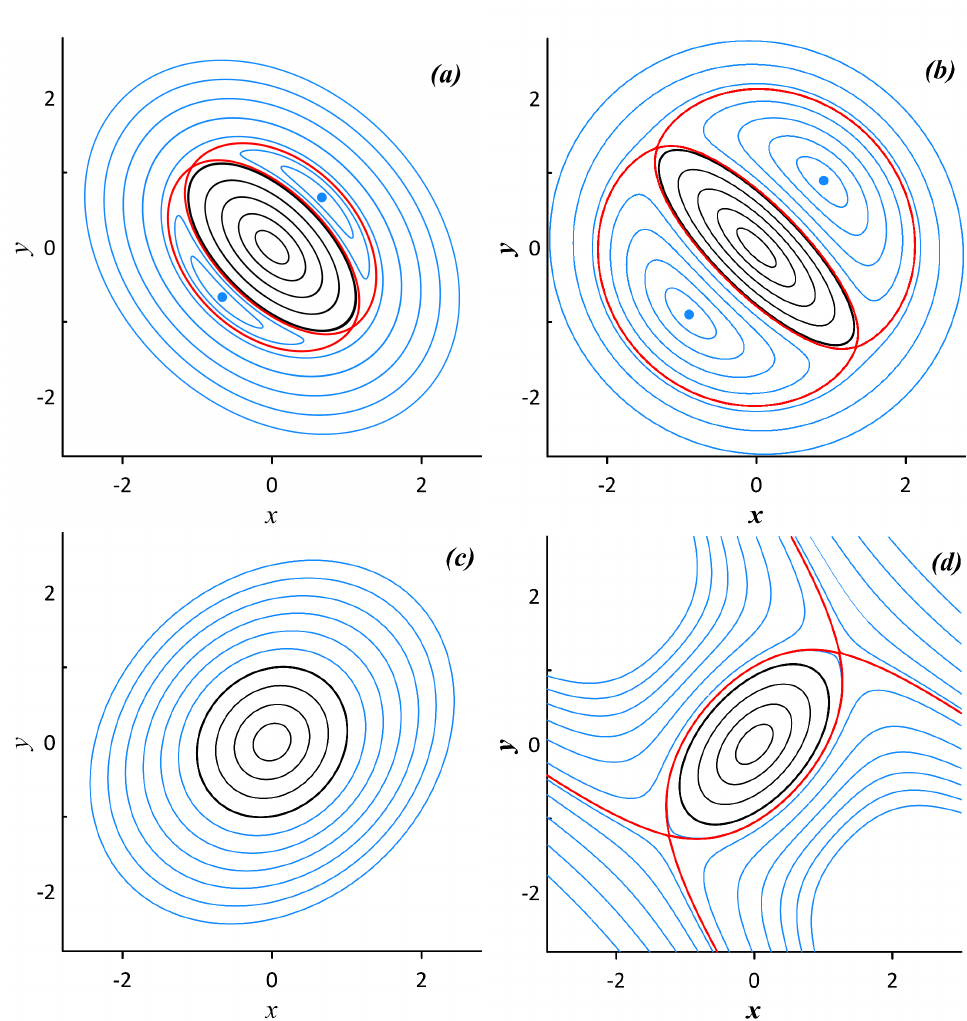
Figure 28. Examples of fluid particle trajectory patters induced by a stationary ellipsoidal vortex corresponding to various regimes of the ellipsoidal vortex’s orientation against the exterior deformation flow: ( a ) e = 0.1, γ = − 0.4, (cid:101) 0 = 1.9975, and θ = − π ( c ) e = 0.1, γ = 0.4, (cid:101) 0 = 1.163625, and θ = π The boundary of the vortex is marked by a black line. The red line shows the